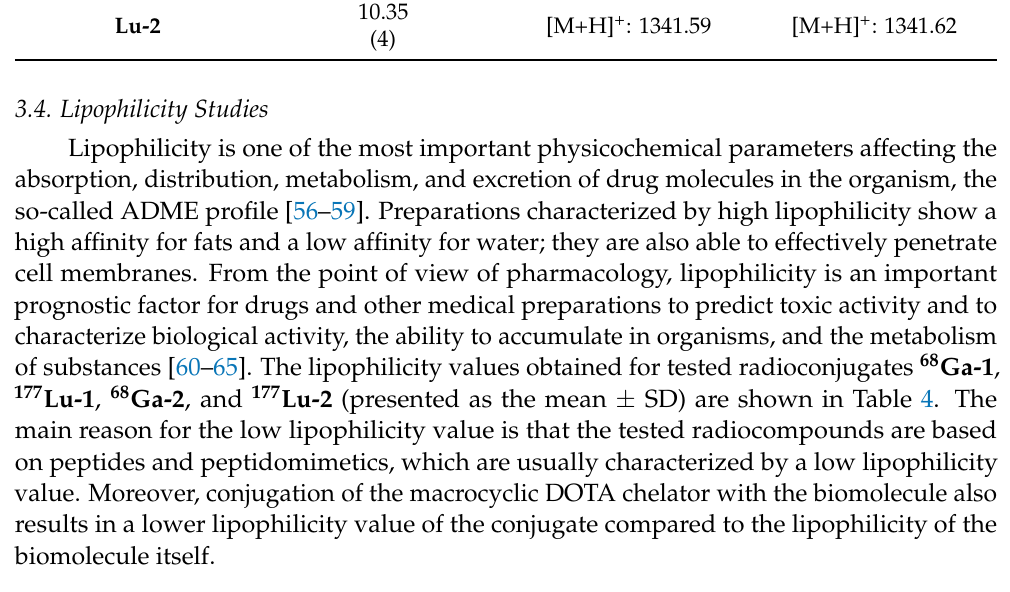
Table 4. R T and logP values of the tested